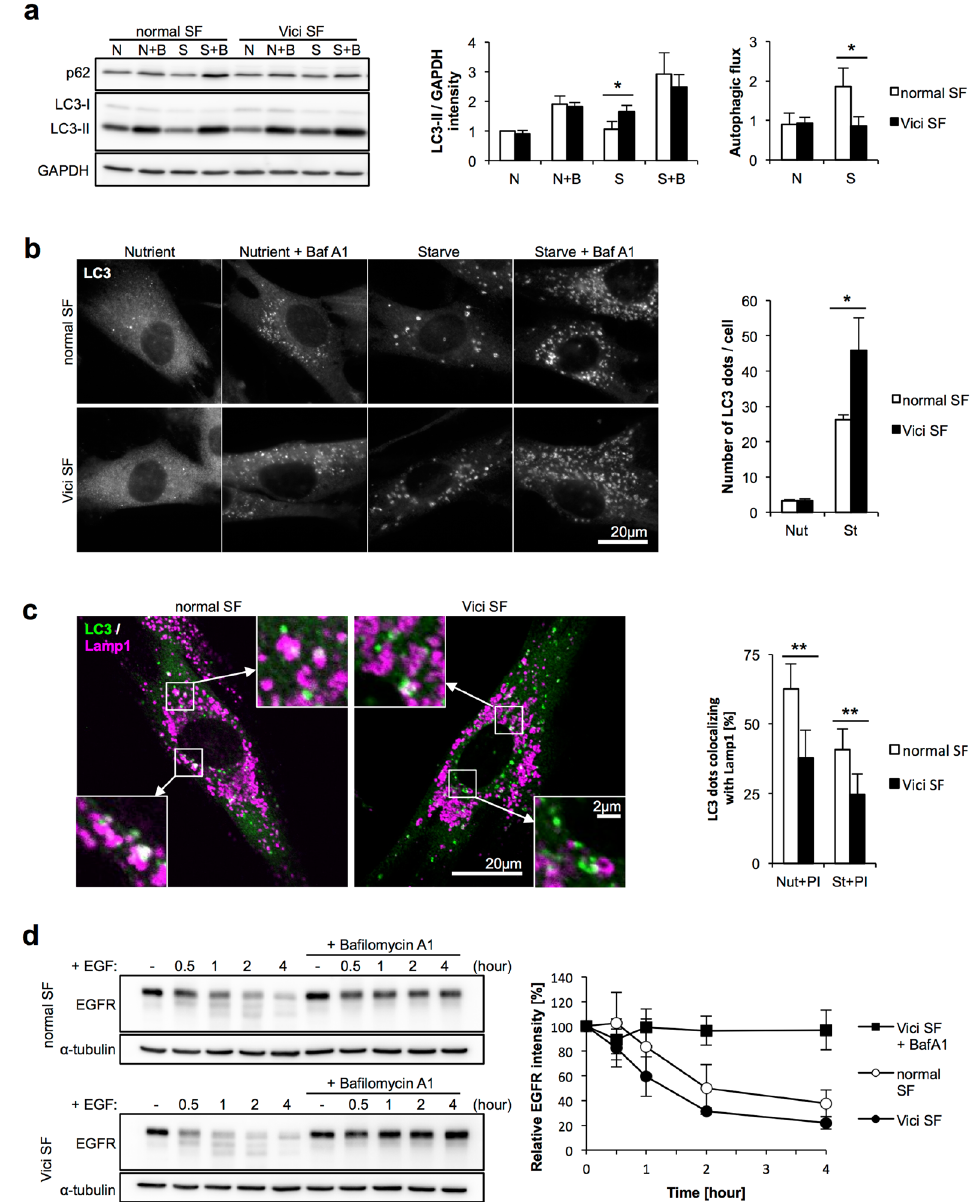
Figure 2. Mild autophagic impairment in VICIS SFs. ( a ) Normal and VICIS SFs were incubated in nutrient- rich or starved conditions with/without BafA1 for 6 hours. A representative western blot of LC3 and p62, and quantitative analysis of band intensities are shown. LC3 intensities were standardized by GAPDH intensities, and values relative to that of normal cells in nutrient-rich conditions without BafA1 are shown. Autophagic flux was calculated by subtracting values for BafA1 untreated samples from treated samples in each condition. Upon starvation, VICIS SFs exhibited mild accumulation of LC3-II and reduced autophagic flux. p62 is another substrate which is degraded by autophagy, but it showed little variation in expression. ( b ) SFs were incubated in nutrient-rich or starved conditions with/without BafA1 for 2 hours, followed by LC3 immunostaining. Representative images and quantified numbers of punctate LC3 staining per cell are shown. Under starved conditions, LC3 punctate staining was higher in VICIS SFs compared with normal SFs, which is consistent with the increased intensity of the LC3-II band in VICIS SFs under the starved conditions shown in ( a ). ( c ) SFs were incubated in nutrient-rich or starved conditions with/without protease inhibitors for 2 hours, followed by LC3 and Lamp1 immunostaining. Representative images and calculated percentages of punctate LC3 staining colocalized with Lamp1 are shown. Decreased colocalization between LC3 and Lamp1 staining in VICIS SFs indicates reduced autophagosome-lysosome fusion. ( d ) Conventional endocytic pathway activity assessed by EGFR degradation was normal in VICIS SFs. N or Nut, nutrient-rich conditions; S or St, starved conditions; B or BafA1, Bafilomycin A1; PI, protease inhibitors (E64d + pepstatin A). Mean and SD from at least three independent experiments with 10 images assessed per treatment condition. Statistics by two-tailed Student’s t - test; * p < 0.05, ** p <